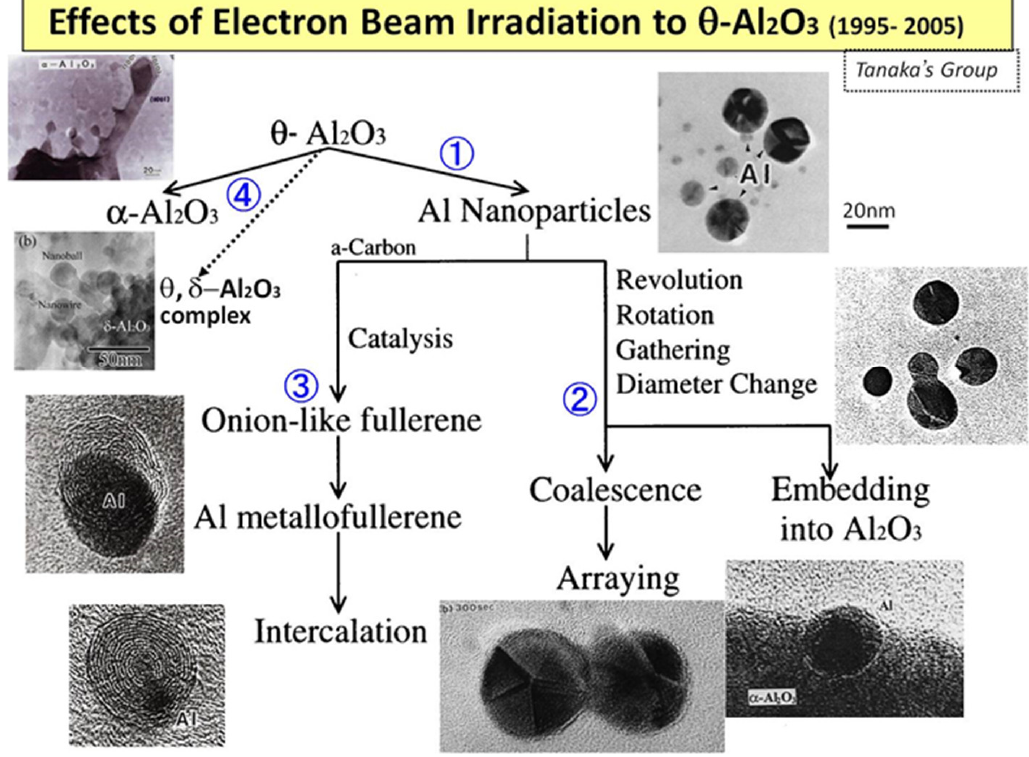
Figure 1. Evolution of the reactions and nanostructures induced by electron beam irradiation of metastable θ -Al 2 O 3 in TEM. Numbers ① – ④ denote the reaction routes explained [1].